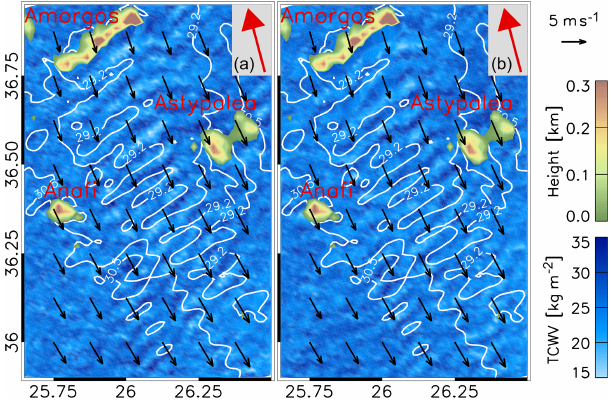
Figure 4. AIRWAVE TCWV (bluish colours) for 2 August 2002 over Aegean Sea, derived from ATSR-2, orbit 38086 (ascending), with measurements acquired from 20:11:41 to 20:12:00 (a) , and AATSR, orbit 2214 (ascending), with measurements acquired from 19:43:11 to 19:43:30 (b) . The black arrows represent wind speed (length) and direction, as derived from ERA-Interim fields interpo- lated at 0 . 125 ◦ × 0 . 125 ◦ resolution. TCWV as computed from WRF model run (output at 20:00:00) is superimposed as white contour lines for two specific values of 29.2 and 30.5kgm − 2 . The top-right box shows the satellite flight